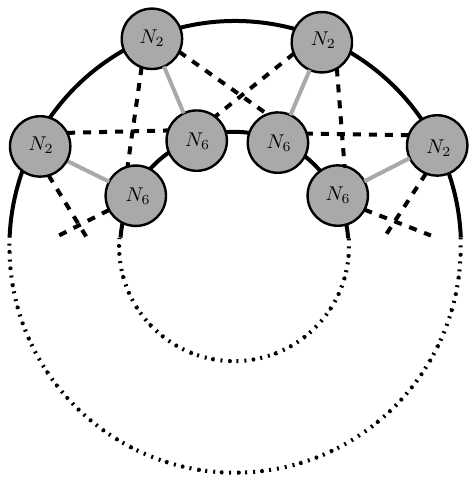
Figure 6 . Circular quiver associated to the (orbifolded) ATD